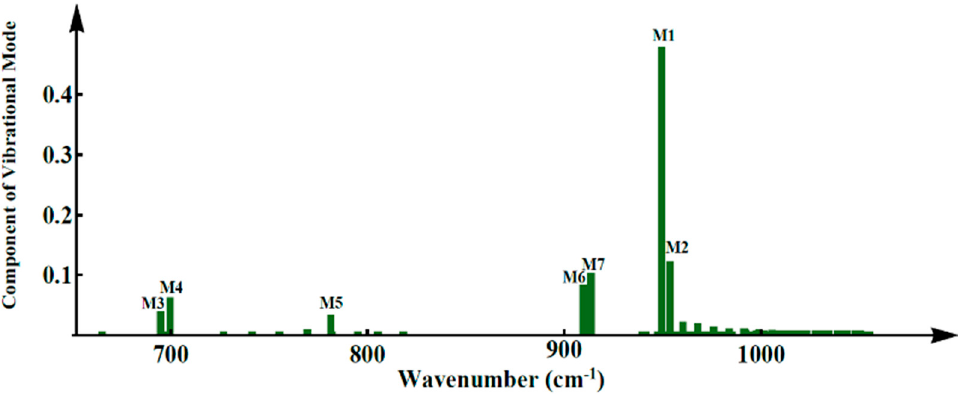
Figure 5. Phonon spectra of ASE under pumping by an external laser of 70 µJ/cm 2 .